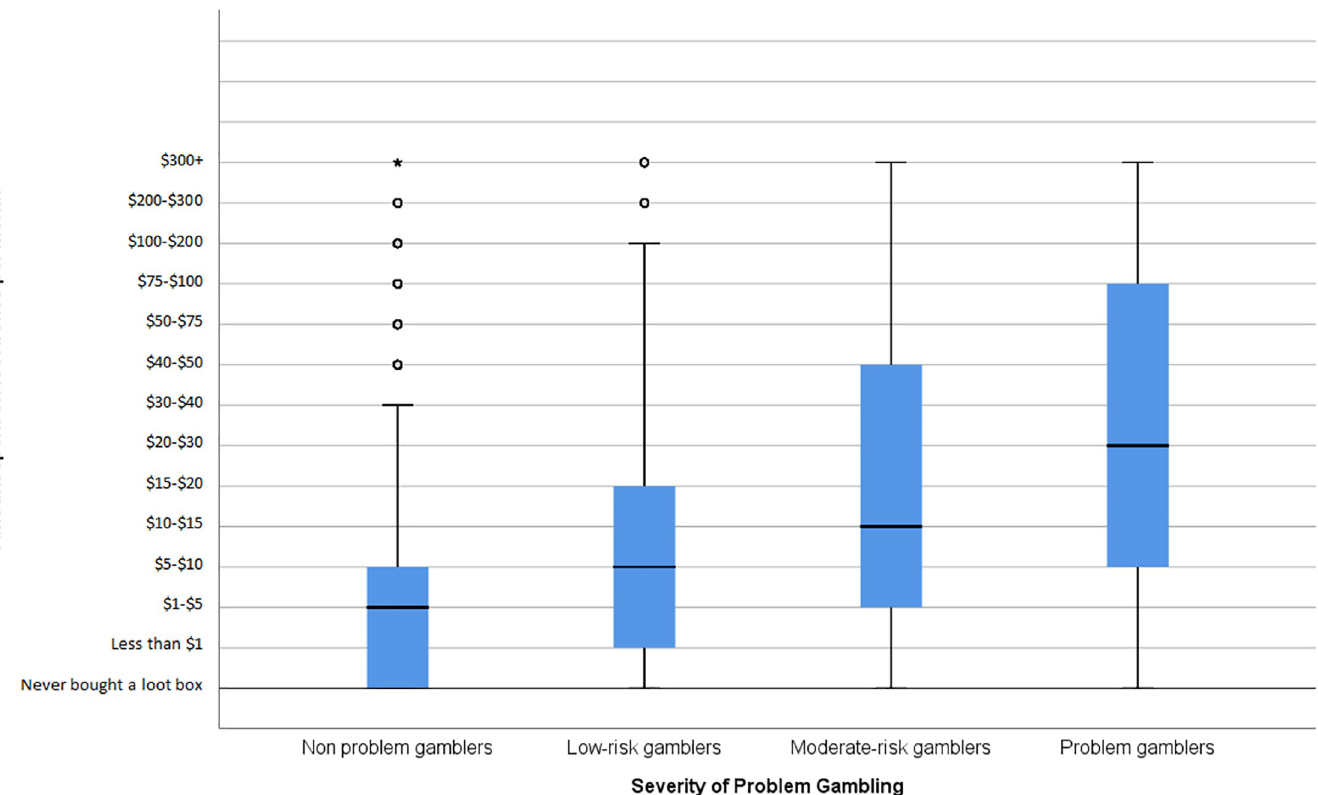
PLOS ONE | https://doi.org/10.1371/journal.pone.0206767 November21,